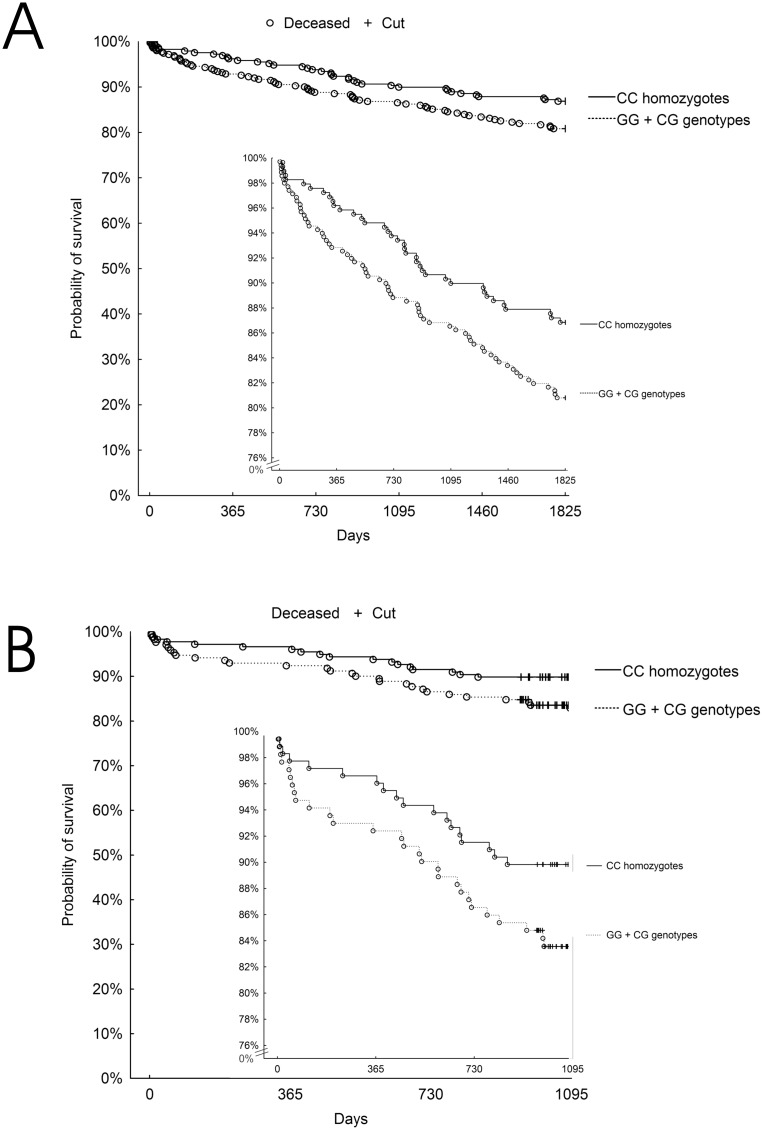
Kaplan-Meier survival curves for CC homozygotes and G-allele carriers of the rs12526453 SNP in the derivation group (panel A) and in the validation group (panel B).The differences between the groups were statistically significant (p = 0.017 in the derivation group and p = 0.031 in the validation group, Cox`s F test).